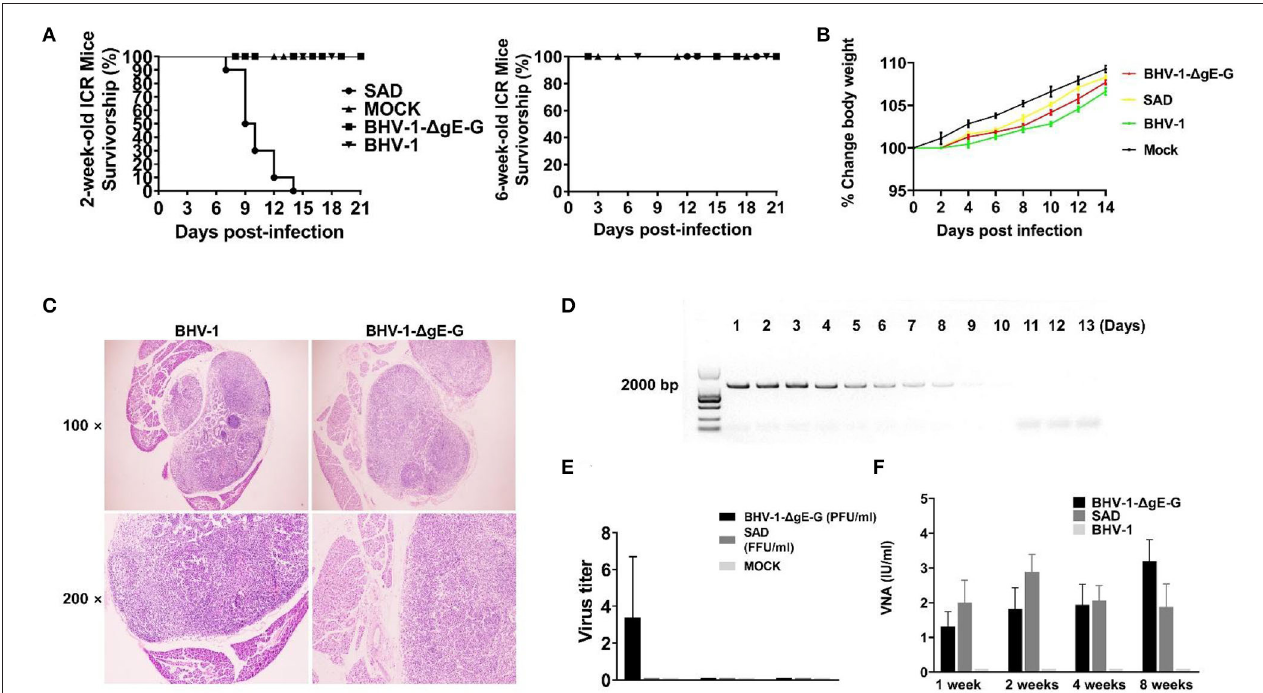
FIGURE 2 | Clinical observations and VNA persistence in mice that administrated SAD and BHV-1- 1 gE-G via the IM route. (A) The survivorship of 2-week-old and 6-week-old female ICR mice inoculated with the indicated virus via IM route. (B) Body weight change (%) was evaluated in mice which were injected with the indicated virus via the IM route. (C) Inguinal lymph nodes were obtained from immunized mice and subjected to HE staining. (D) The gB gene expression in mice inguinal lymph nodes that were immunized with BHV-1- 1 gE-G was detected by PCR and analyzed with electrophoresis. (E) The inguinal lymph nodes were obtained from mice immunized with the indicated virus and evaluated the virus titer. (F) The serum of mice inoculated with the indicated virus was subjected to RFFIT for the analysis of